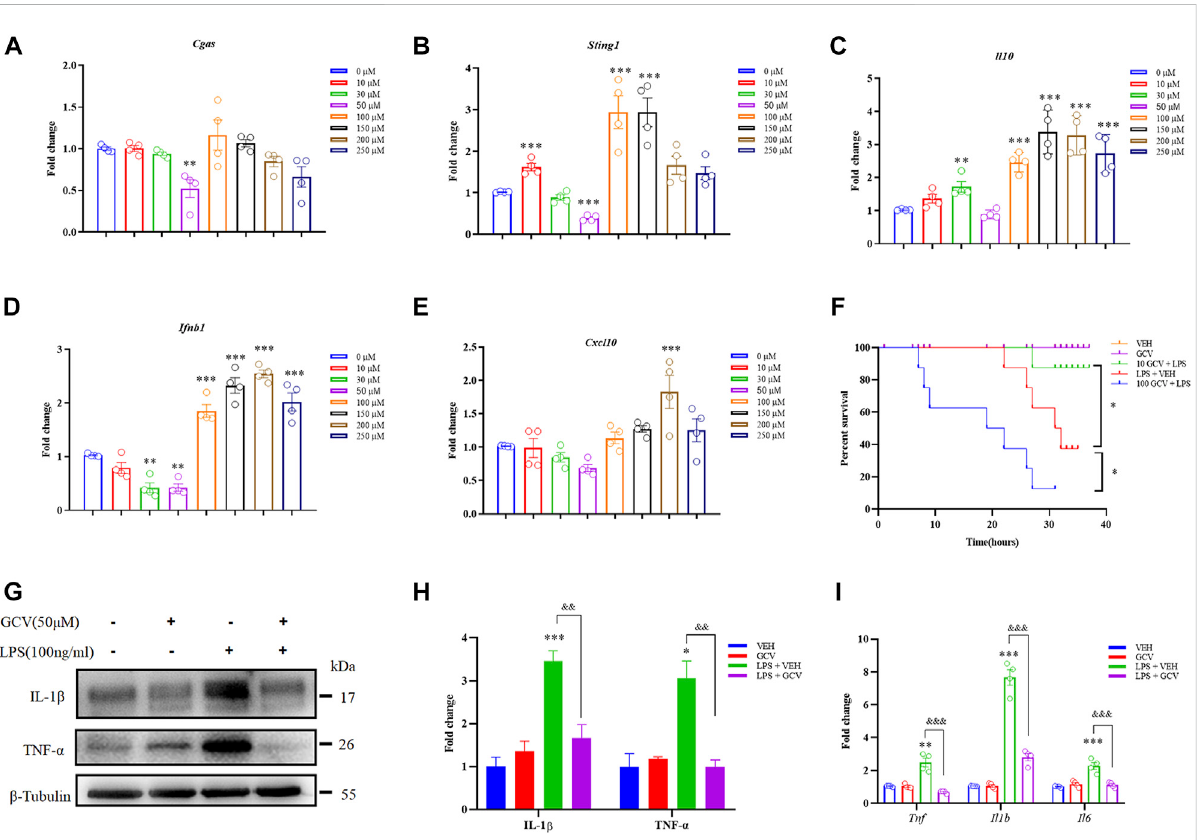
FIGURE 1 Effects of GCV on expression of in fl ammatory factors in RAW264.7 cells. (A – E) Q-PCR analysis showed dose-dependent effects of GCV treatment for24 honthemRNAexpressionof Cgas (A) , Sting1 (B) , Il10 (C) , Ifnb1 (D) ,and Cxcl10 (E) inRAW264.7cells. (F) Dose-dependenteffectsof GCV treatment on the mortality associated with LPS-induced sepsis in mice. ( n = 7-8 per group; * p < 0.05; Log-rank test). (G) Western blotting analysis showing the effect of GCV on LPS-induced expression of IL-1 β and TNF- α in RAW264.7 cells. (H) Statistical analysis results of (G) . (I) Q-PCR analysis the effect of GCV on LPS-induced mRNA expression of Il6 , Il1b , and Tnf in RAW264.7 cells. ( n = 4 each group, * p < 0.05, ** p < 0.01, *** p < 0.001 vs. saline; && p < 0.01, &&& p < 0.001 vs. LPS group, unpaired Student ’ s t -test). All data was expressed as Mean ± SEM. n.s., no signi fi